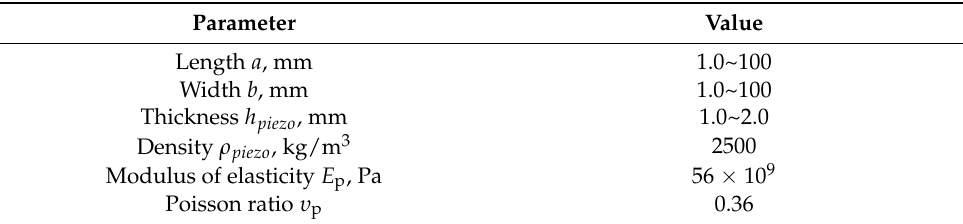
Table 2. The piezoelectric patch